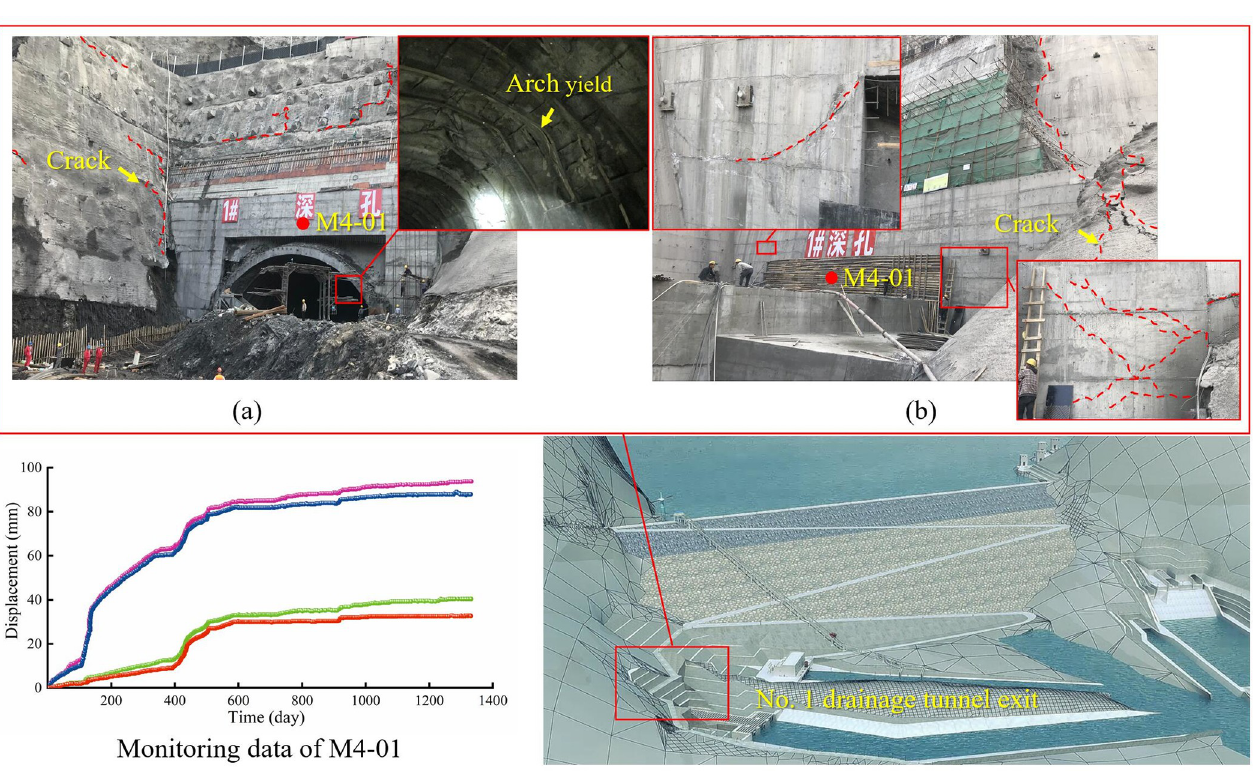
Fig 1. Deformation and safety problems of the No. 1 drainage tunnel: (a) initial support, (b) secondary support.